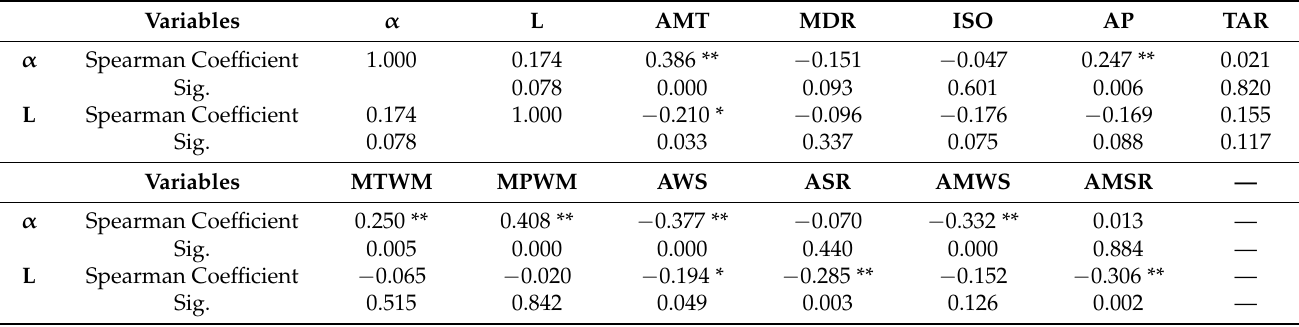
Table 2. The relationship between the climatic element and the roofing element.